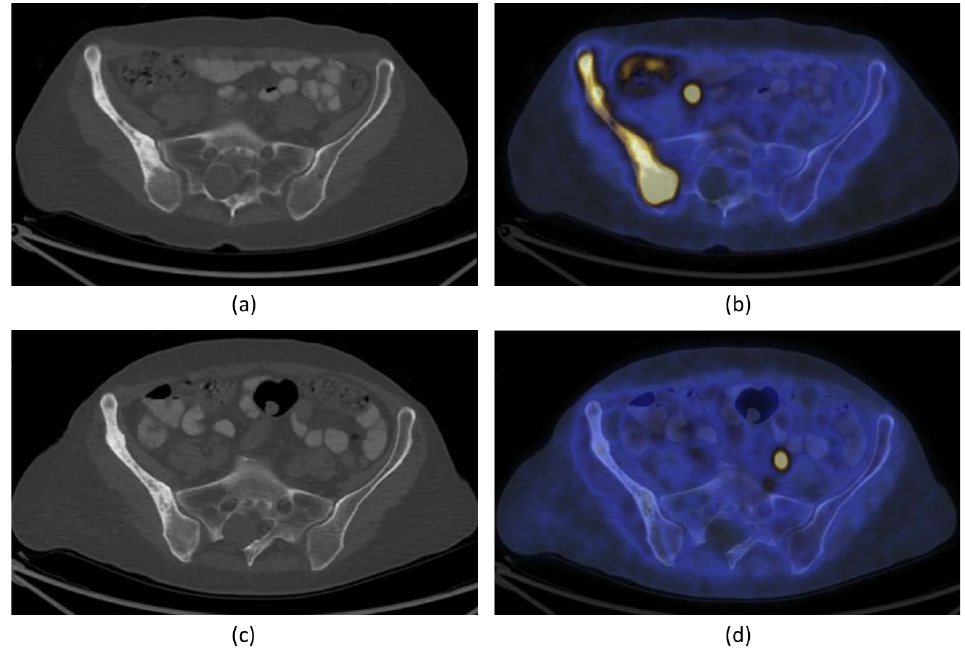
Figure 5. A 66-year-old woman with bone metastasis in the right ilium. Trans-axial 18 F-FDG PET/CT slide at the level of the pelvis ( a ): CT; ( b ): fused PET/CT) demonstrates pathological increase in 18 F-FDG uptake in a larger mixed lytic-sclerotic lesion before treatment. After MR-HIFU treatment, no 18 F-FDG uptake was observed in the right ilium ( d ). There is, however, no change in the bony structure on CT ( c ). The findings are consistent with healed metastasis in the right ilium with no evidence of active residual malignancy in the site. FDG = fluorodeoxyglucose; PET = positron emission tomography; CT = computed tomography). Figures adapted and reprinted from Journal of Pain and Symptom Management, Volume 56 Issue 1, Eisenberg E, Shay L, Keidar Z, Amit A, and Militiau D, Magnetic Resonance–Guided Focused Ultrasound Surgery for Bone Metastasis: From Pain Palliation to Biological Ablation?, 158–162, 2018, with permission from Elsevier (Amsterdam, The Netherlands)